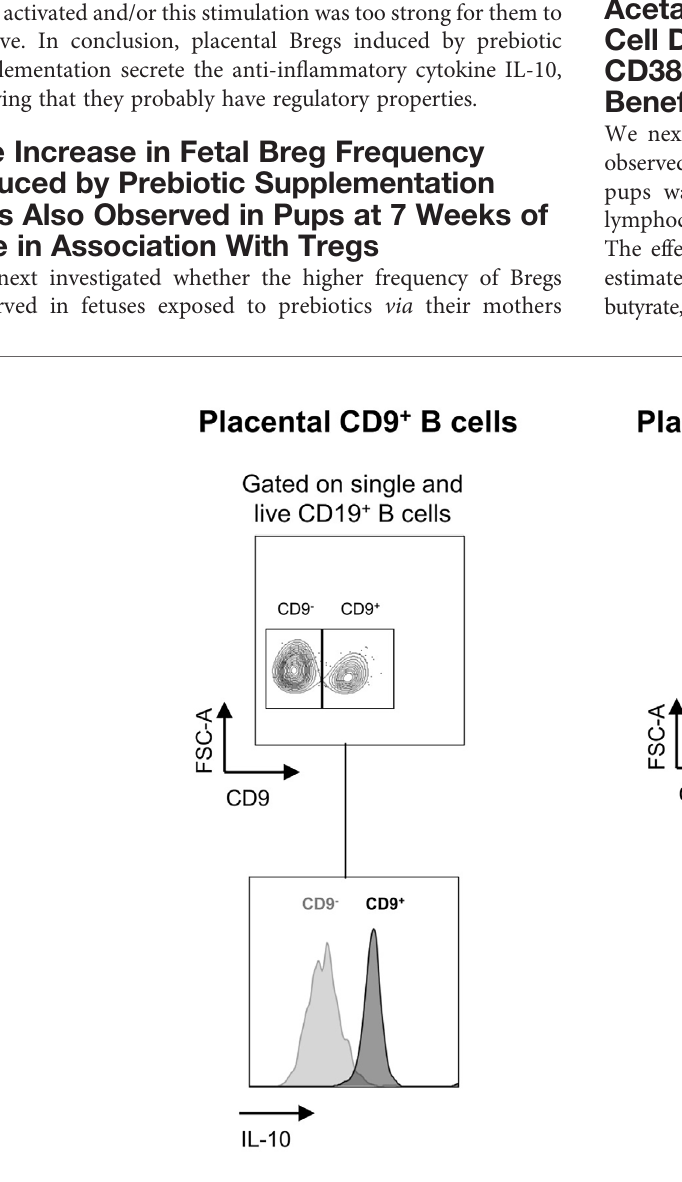
FIGURE 7 | Estimation of IL-10 secretion in CD9 +/- and CD25 +/- placental B cells induced by GOS/inulin supplementation. Determination of IL-10 secretion by CD9 + , CD9 - , CD25 + and CD25 - B cells in the placenta of dams supplemented with GOS/inulin during gestation by intracellular